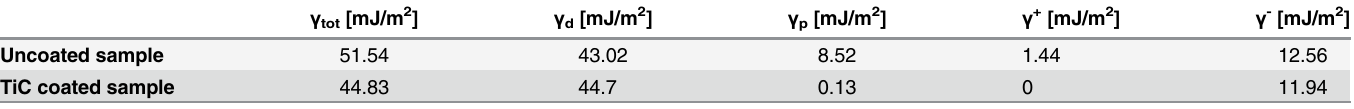
Table 2. Surface free energy parameters for uncoated and TiC coated titanium